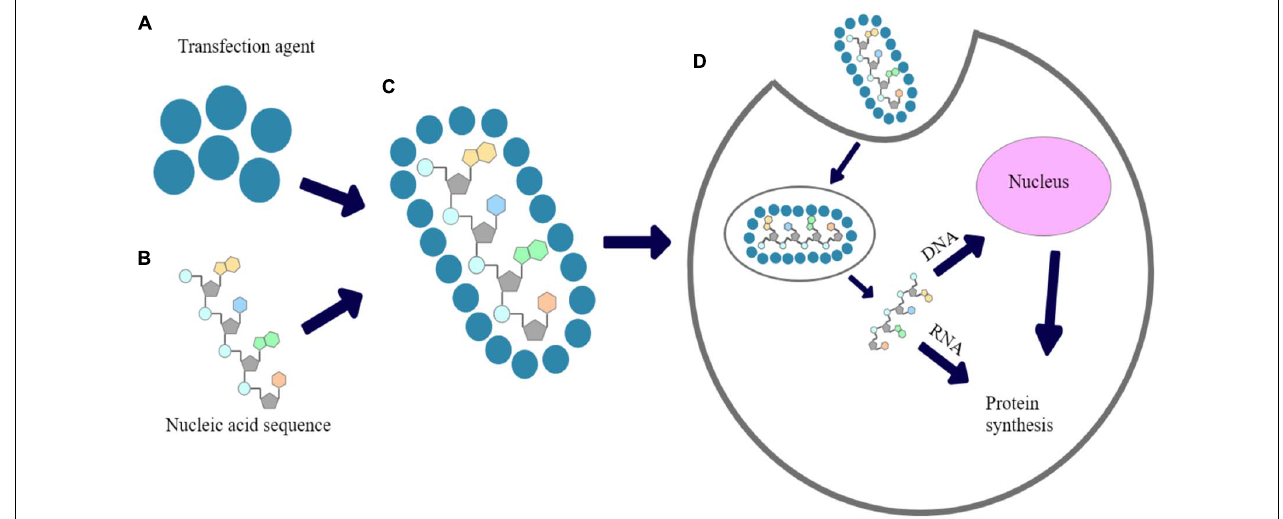
FIGURE 1 | The proposed mechanism of chemical transfection: (A) transfection reagent; (B) Nucleic acid sequence; (C) nucleic acid polyplexed with chemical transfection reagent; (D) cellular uptake of polyplex and expression of introduced nucleic acid’s fragment.